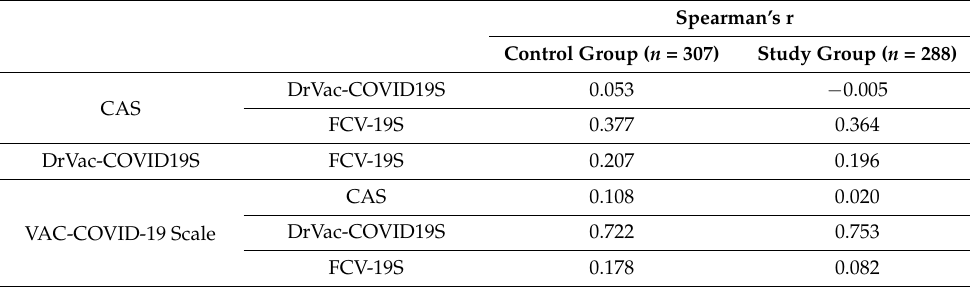
Table 6. Inter-scale correlations by